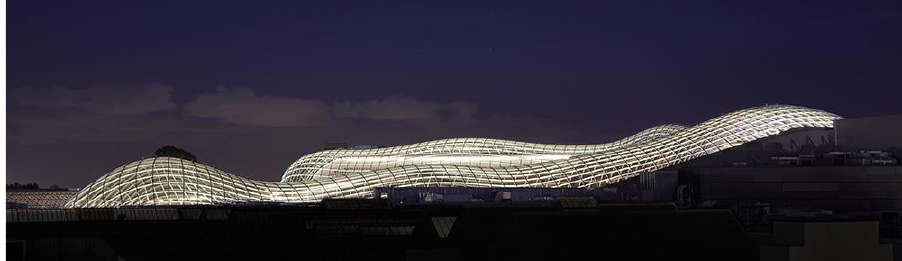
Fig. 6 Chadstone Shopping Mall in Melbourne,